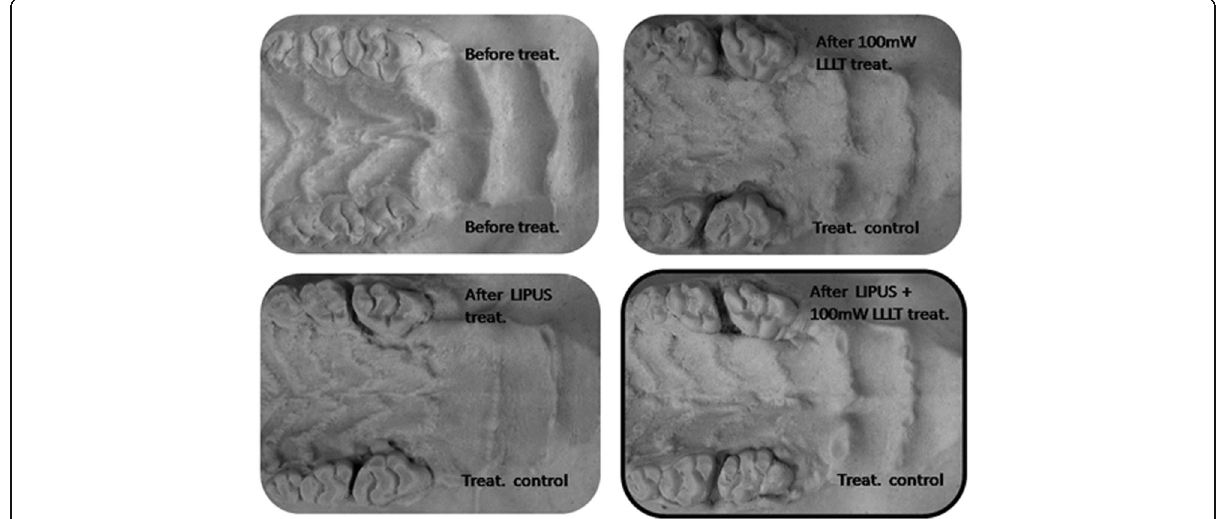
Fig. 4 Study model images showing the effect of LLLT, LIPUS, and combination of them on orthodontic tooth movement in rats at day 21